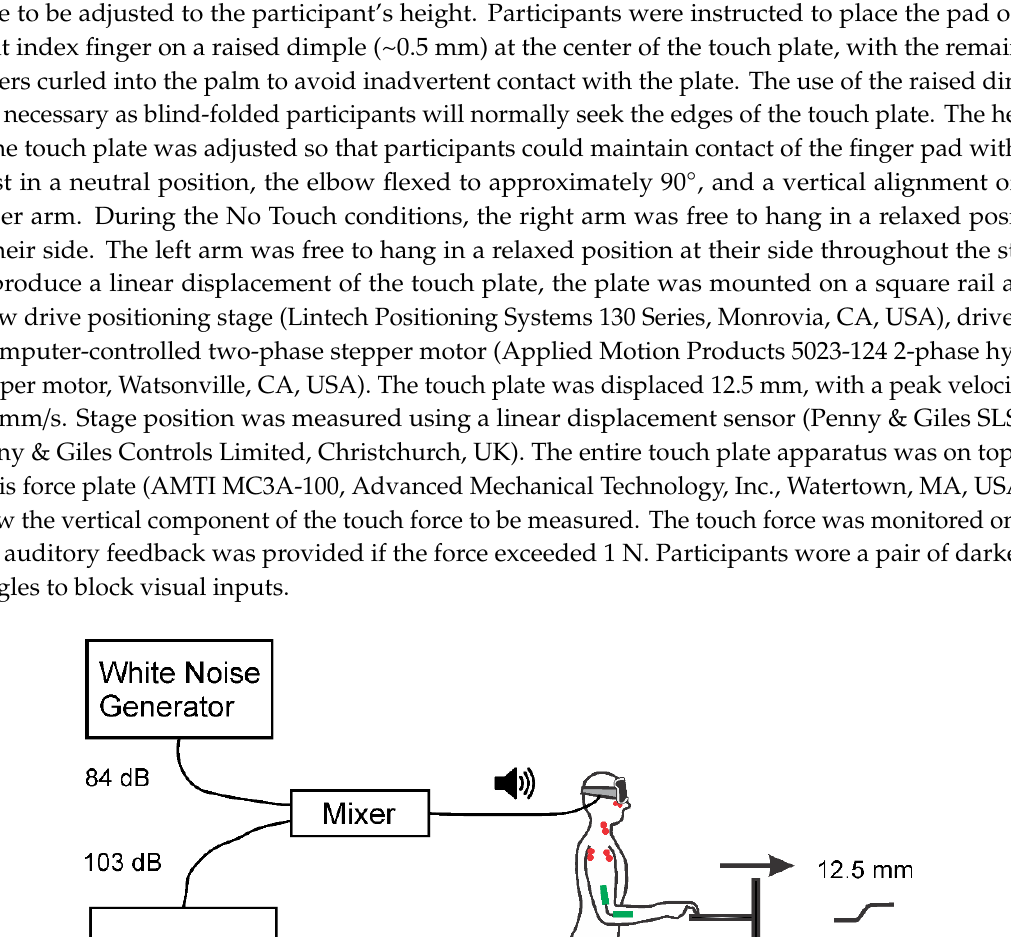
National Instruments, Austin, TX, USA) and consisted of a 150 ms, 450 Hz tone delivered with a peak